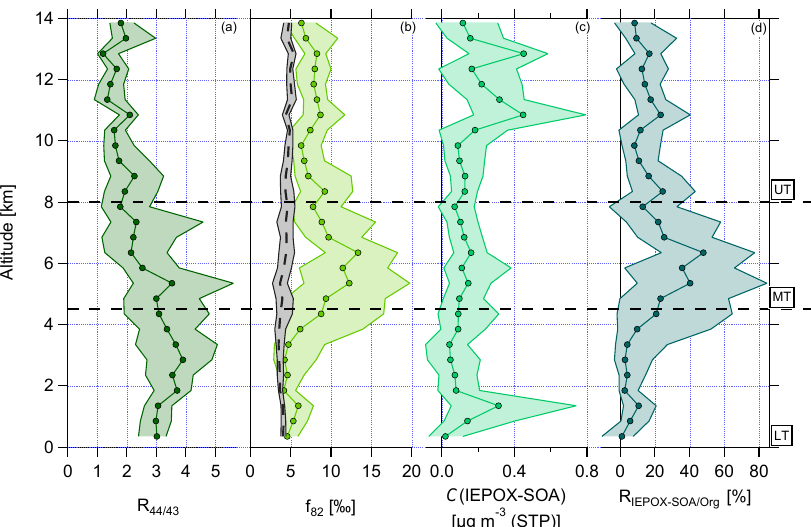
Figure 5. Vertical profiles with medians and interquartile ranges of (a) R 44 / 43 , (b) f 82 , (c) C( IEPOX-SOA ) , and (d) R IEPOX-SOA/Org . Horizontal dashed lines indicate divisions into the LT with BL, MT, and UT. The vertical dashed line in (b) presents the calculated median background values f Bg with interquartile ranges using Eq. (3). This equation is valid for areas with strong monoterpene influence (Hu et al., 82 2015, Appendix